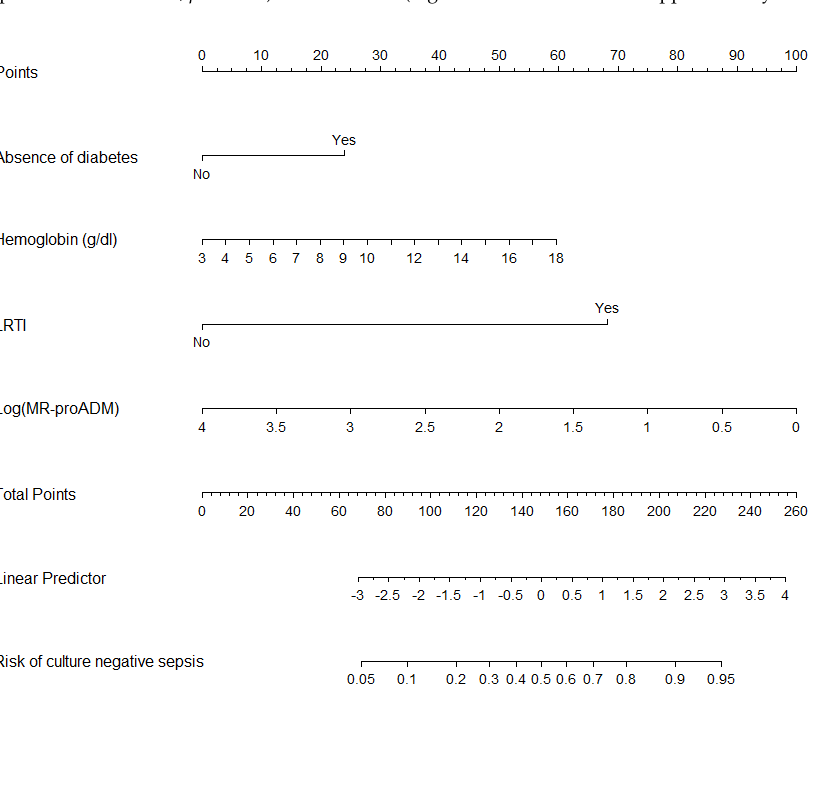
List of abbreviations: CnS = culture negative sepsis, CpS = culture positive sepsis. * The definition of each organ dysfunction and that of multi-organ failure are available in the Supplementary Materials (PDCS). A significant trend towards a positive linear correlation between serum concentrations of MR-proADM and SOFA score (Spearman rho = 0.478, p < 0.001) was observed (Figure S1 available in the Supplementary